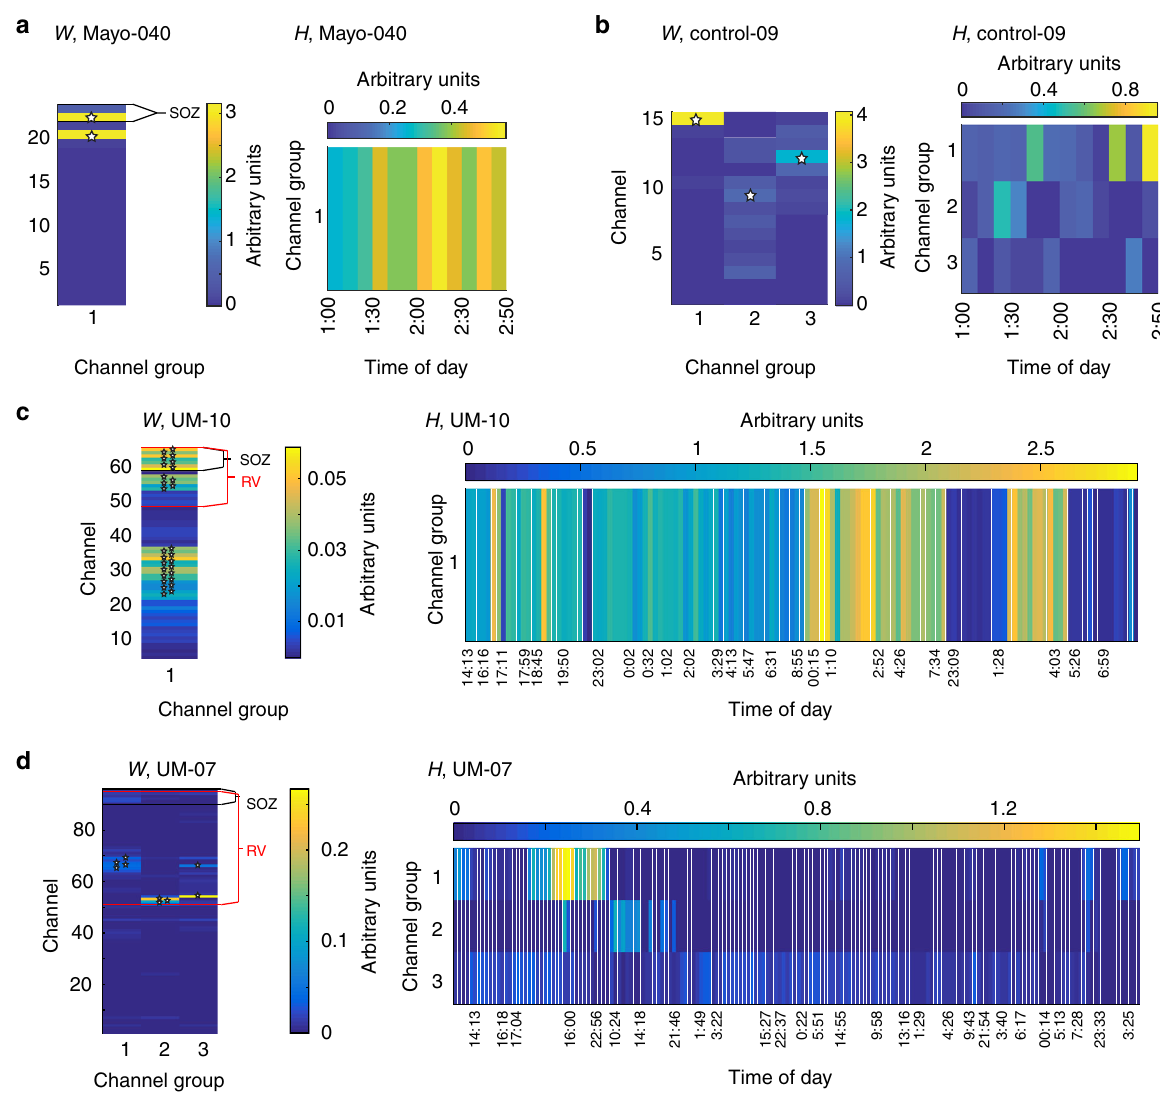
Fig. 3 Blind source separation of HFO rates. Each of the HFO rates presented in Fig. 1 are decomposed into groups of channels. The associations of each channel with each group ( a – d , left), denoted by W , and each time epoch ( a – d , right), denoted by H , are shown for each example patient. Denoting the rates in Fig. 1 by the matrix R , the blind source separation satis fi es the matrix product R = W × H . White stars indicate the channels most involved with each source, which are color coded in Fig.